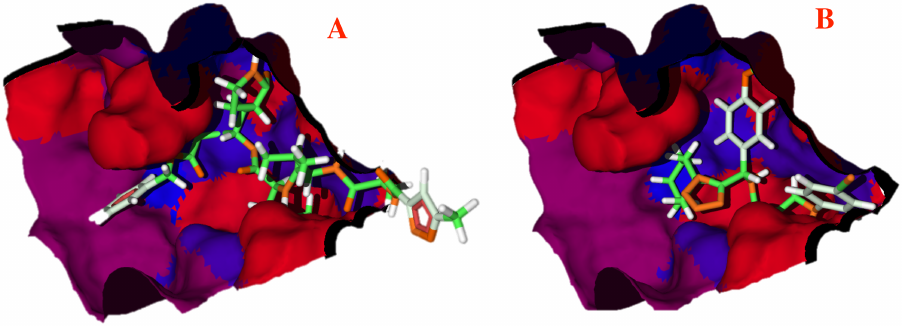
Figure 5 Hydrophobic interactions between the CoV-2-M Pro protein and the main ligands. Hydrophobic interactions between the Cov-2-M Pro protein and (A) the co-crystallized ligand, and (B) 1e. Blue surfaces represent hydrophobic sites, red surfaces are hydrophilic zones.